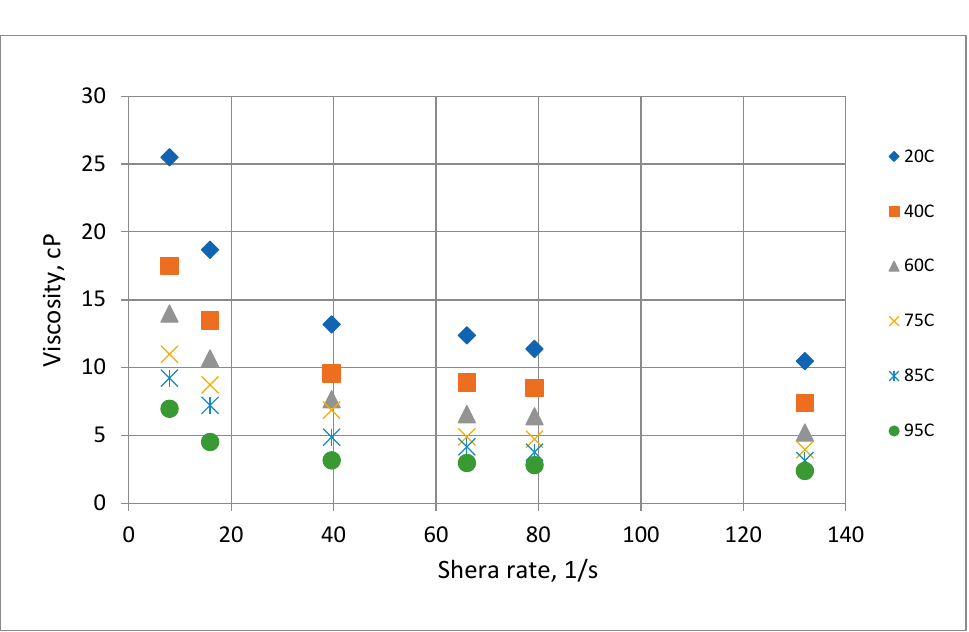
Figure 6. Viscosity of OM polymer versus shear rate with different testing temperatures in seawater.